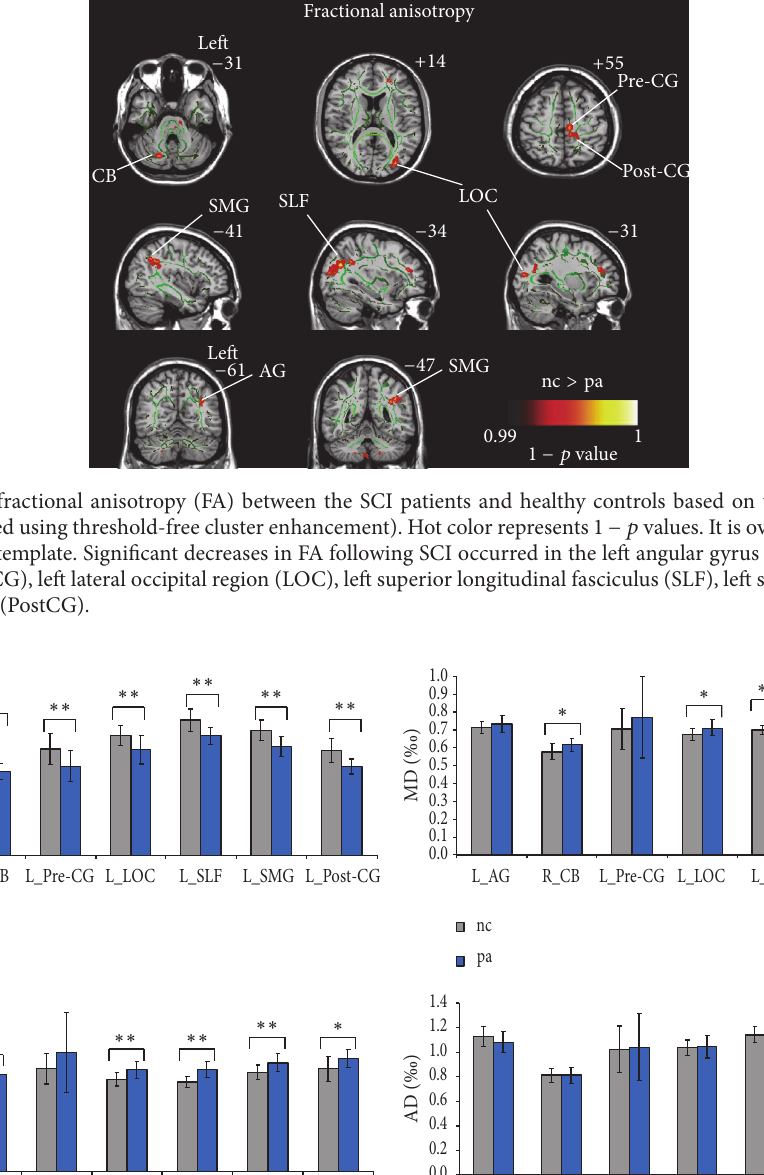
( 𝑞 < 0.05 , corrected using FDR or uncorrected 𝑝 <